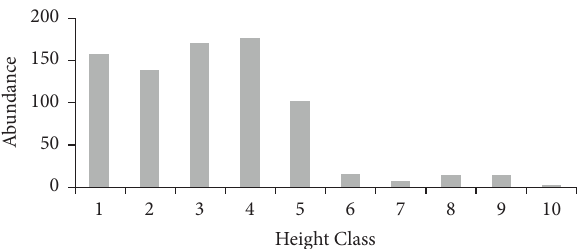
Figure 5: Height class frequency distribution of woody species. Key: numbers represent the height class; (1) (2.0–4.50m), (2) (4.51–7.0m), (3) (7.01–9.50 m), (4) (9.51–12.0m), (5) (12.01–14.50m), (6) (14.51–17.0m), (7) (17.01–19.5m), (8) (19.51–22.0m), (9) (22.01–24.50m), and (10) ( > 24.50 m) of Zijje Maryam Church Forest/2020. Table 2: Basal area comparison of the current study with some other studies conducted in Ethiopia where the vegetation data were collected in the same DBH. Study sites DBH Basal area (ha − 1 )